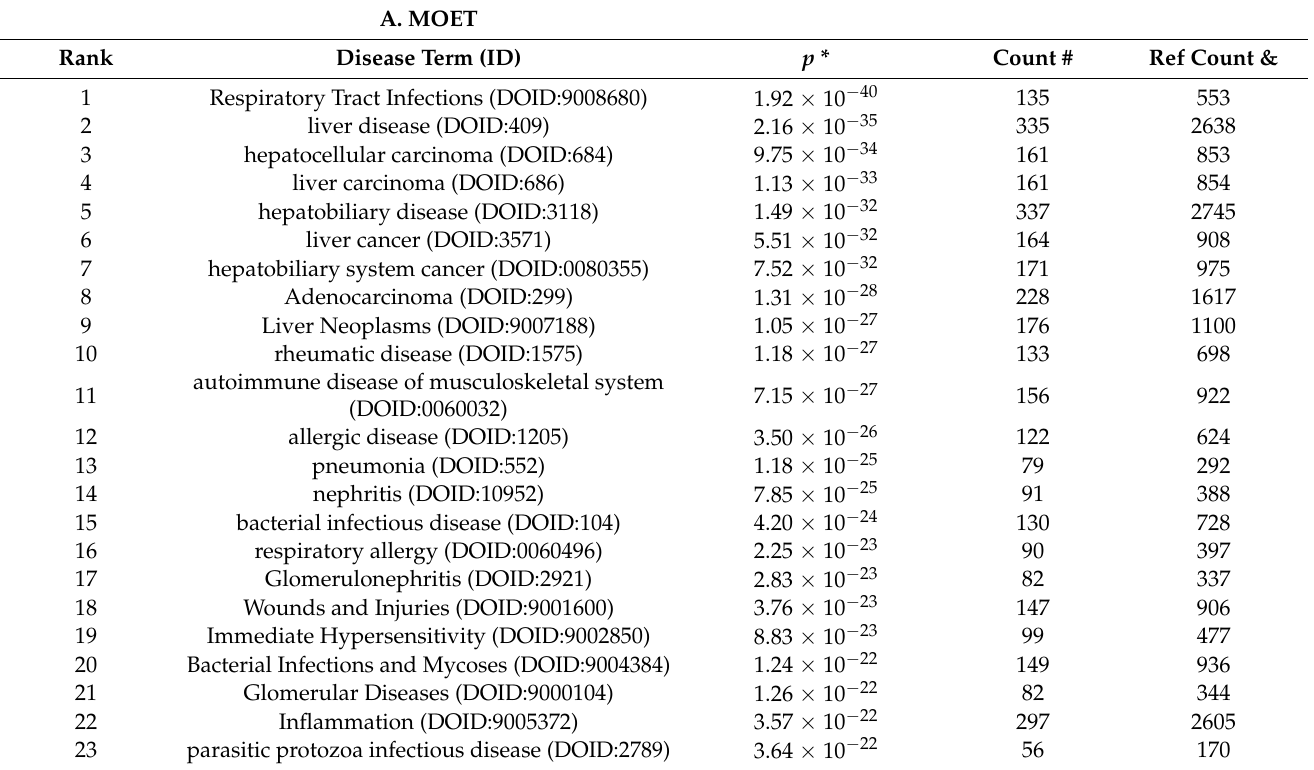
Table 2. A. Top 40 enriched disease terms identified by MOET and Set Analyzer. * The Bonferroni corrected p -values are shown; #, the number of the COVID-19 related disease gene annotated with the disease term and its child term; &, the number of genes in the reference genome annotated with the disease term and its child terms. MOET, the Multi Ontology Enrichment Tool, https: //rgd.mcw.edu/rgdweb/enrichment/start.html (accessed on 1 June 2022), developed by RGD. Set Analyzer, the enrichment tool developed at CTD (http://ctdbase.org/tools/analyzer.go (accessed on 1 June 2022)). B. * The Bonferroni corrected p -values are shown; #, the number of the COVID-19 related disease gene annotated with the disease term and its child term; &, the number of genes in the reference genome annotated with the disease term and its child terms. Set Analyzer, the